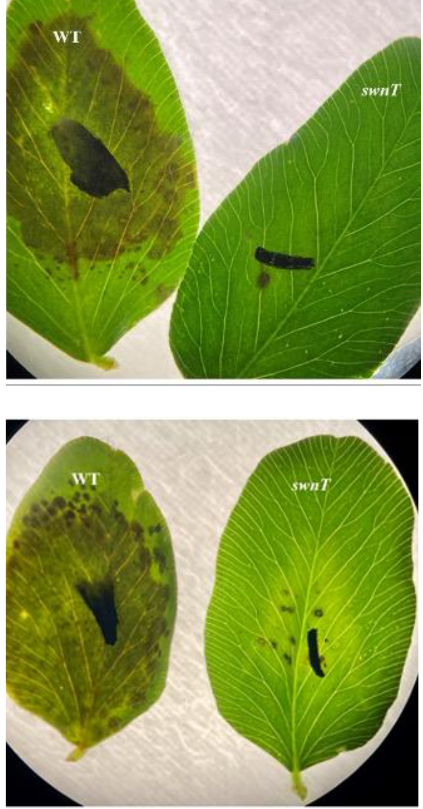
Figure 7. Detached red clover leaves infected with the WT and the T5 pSilent- swnT transformants (4 dpi) (black marks on the leaves were drawn on the leaf at time of inoculation for a point of reference). Detached red clover leaves were inoculated with the T5 swnT transformant and WT five-day-old cultures of S. leguminicola. On day 4 post-inoculation, the leaves inoculated with WT S. leguminicola showed black patch lesions covering almost the entire leaves, while the leaves inoculated with T5 pSilent- swnT transformants showed very few